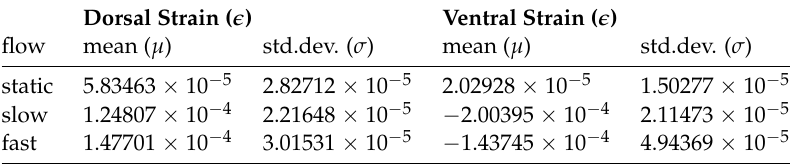
Table 3. Statistics (means, standard deviations) of strain measured on dorsal and ventral gages of the rostrum during horizontal placement in three flows are calculated over 64,000 measurements encompassing the final 200 s of each test, respectively (removing the first 100 s of the full